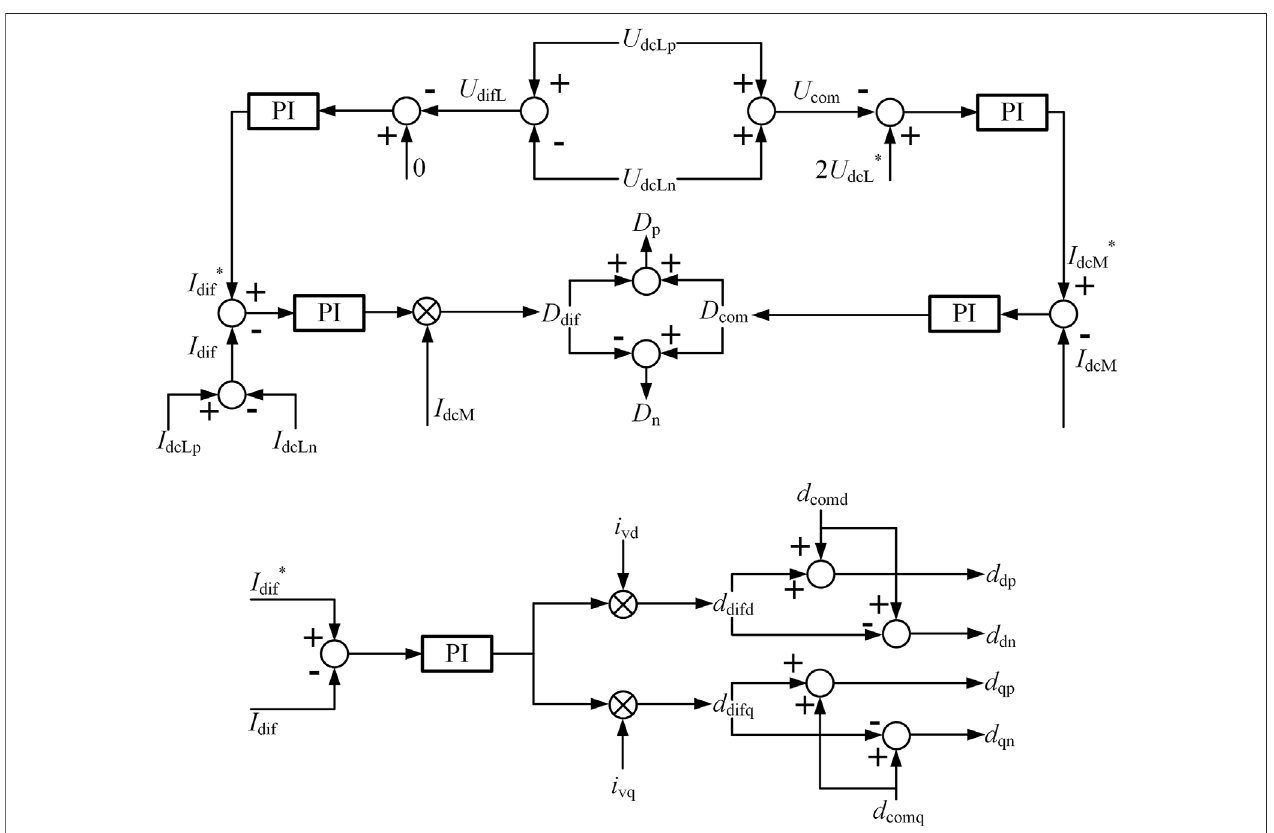
FIGURE 8 | Control diagram of AC differential modulation and DC modulation.